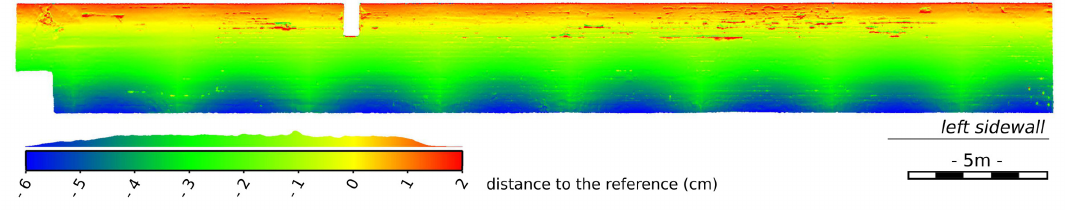
Figure 11. Front view of distances between TLS cloud, with 1 ◦ simulated tilt error, and TLS mesh for the left sidewall.